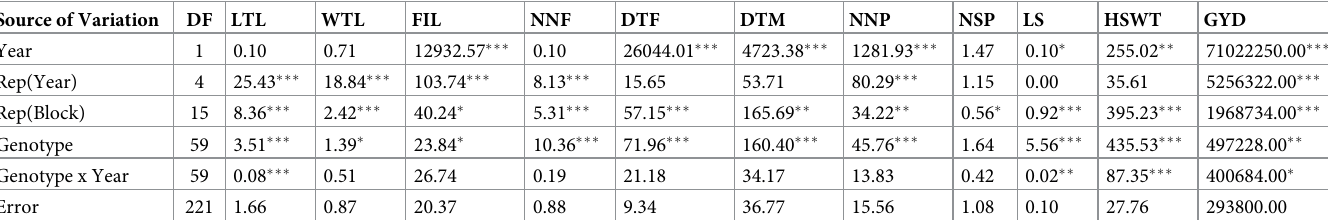
Table 4. Mean squares and signficant tests for 11 quantitative agronomic traits among 60 common bean assessed in two years. Source of